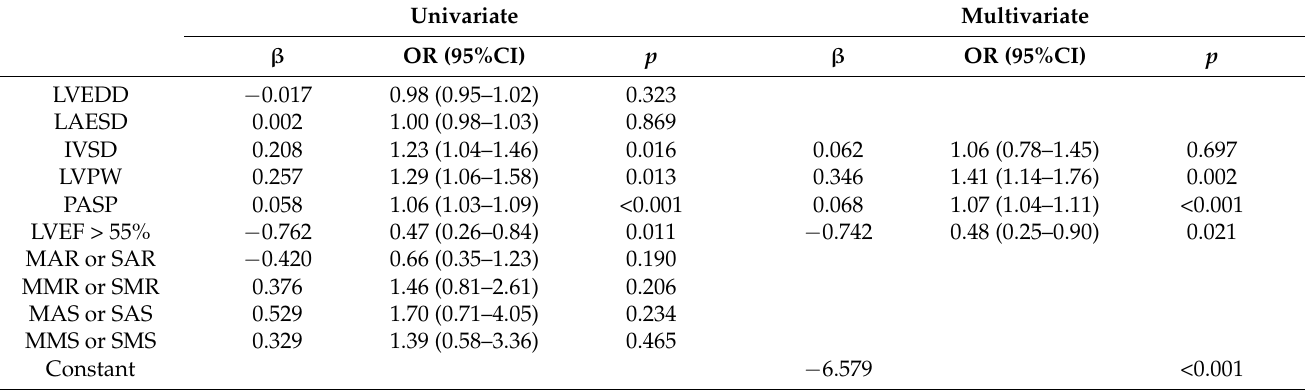
TTEI was calculated based on the ten parameters obtained from TTE by multivariable logistic regression. As shown in Table 2, LVPW, LVEF > 55%, and PASP were found to be independent risk factors for CVS−AKI. Therefore, based on the β coeff icients, the TTEI